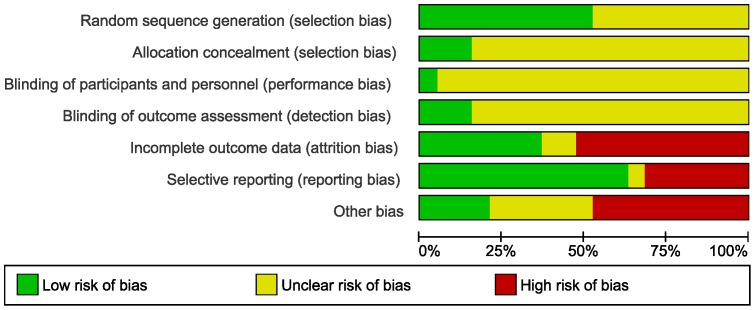
Risk of bias: systematic review authors' judgements about each risk of bias item presented as percentages across all included trials using the Cochrane risk of bias tool (n = 19).